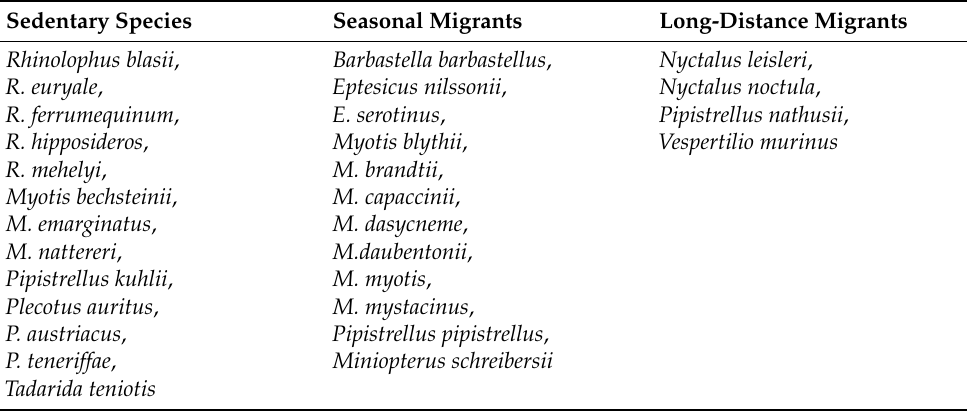
Table 3. Migrating bat species in Europe (sedentary species (up to 100 km of movement), seasonally migrating species (up to 800 km) and long-distance migrants (up to 4000 km))